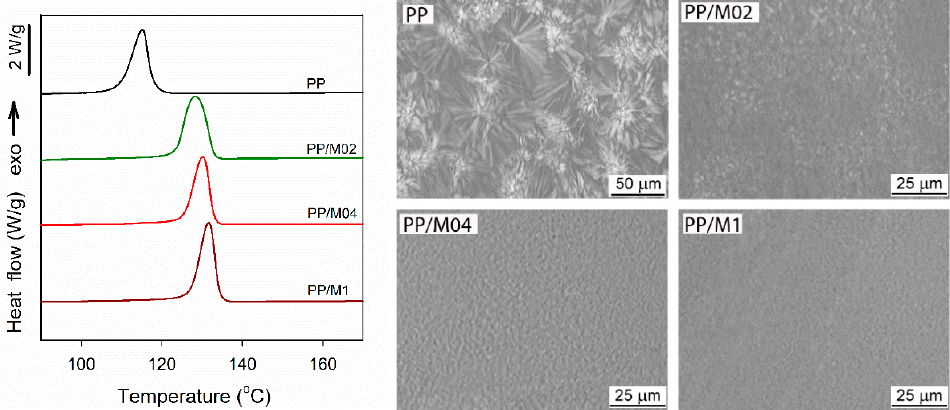
Figure 1. DSC cooling thermograms ( left ), and PLM micrographs of thin sections of neat and nucleated PP crystallized during cooling ( right ).